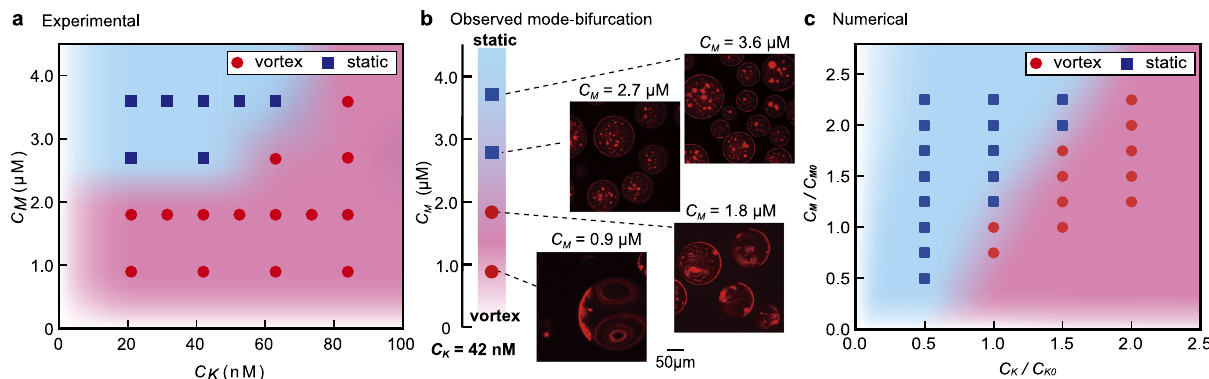
Fig. 4 Behaviour of the phase-separated droplet in the presence of kinesin and MT. a Phase diagram of droplet behaviour according to the kinesin and MT concentrations. Red circles and blue squares correspond to with or without vortical fl ow, respectively. In the upper-left corner of the diagram (low kinesin, high MT concentrations) vortical fl ow was absent and the aggregate formation inside the droplet was noted. b Superimposed fl uorescent images captured every 10 min of droplet motion, at different concentrations of C M . C M ceases the vortical motion. c Phase diagram based on numerical simulation ; C = C fl ow pro fi le shown in Fig. under the assumption described in the main text. C K = C K M M 0 ¼ 1 corresponds to the parameters used to simulate the 0